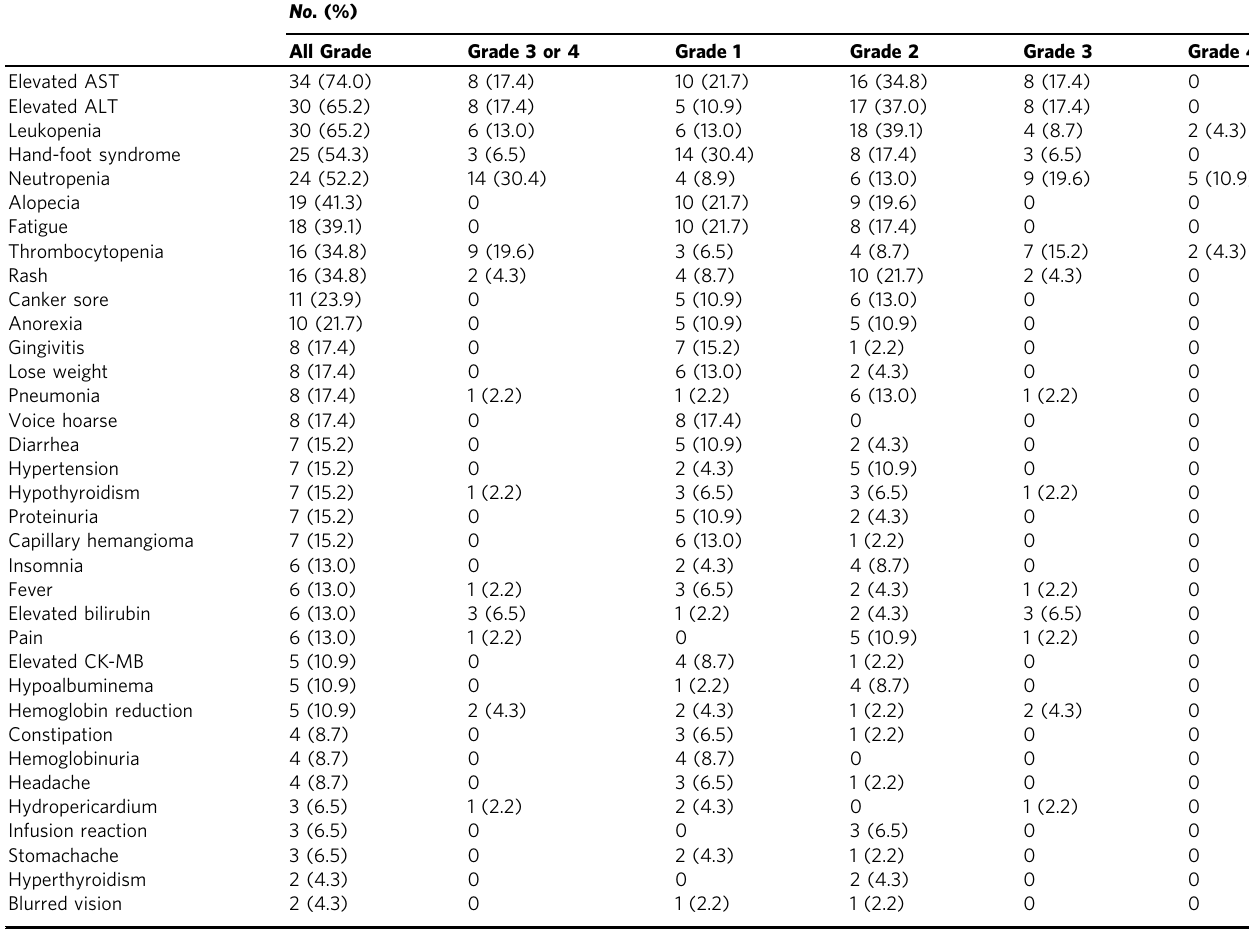
Table 3 Treatment-related adverse events.